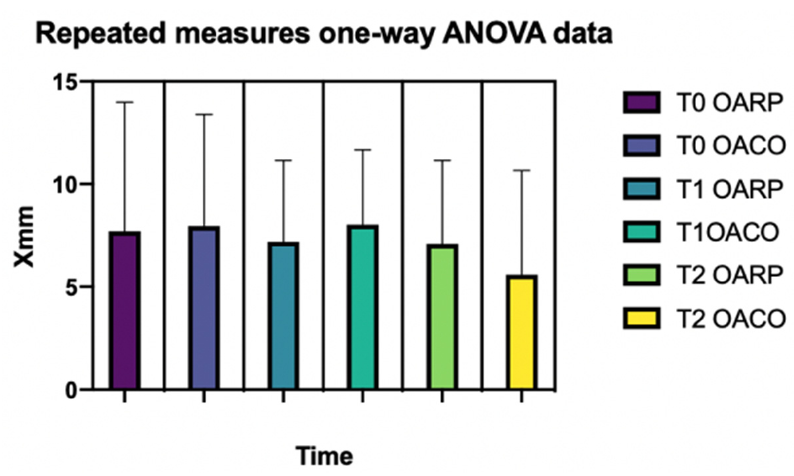
Figure 2. Repeated measures ANOVA mean with standard deviation on barycenter (Xmm). Table 2. Friedman test on weight distribution (WD) .